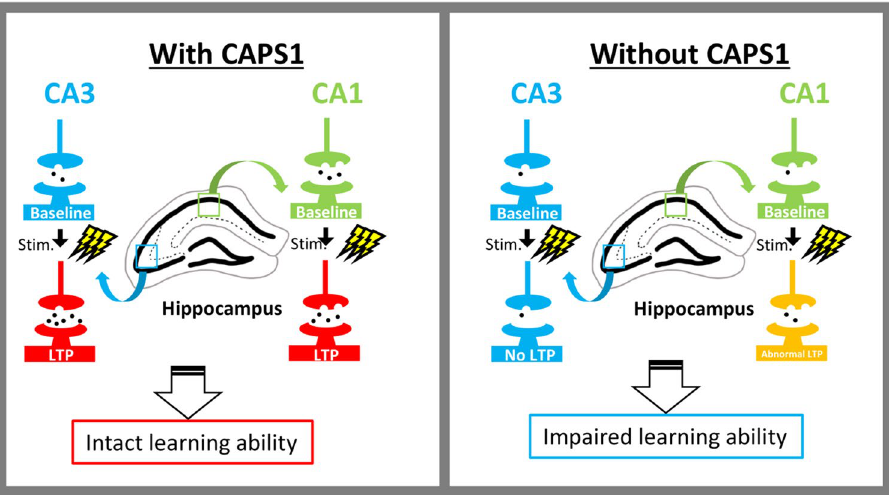
Figure 8. Schematic illustration of the role of CAPS1 in the hippocampal neural circuit and learning ability. Left: Physiological characteristics of the hippocampal neural circuits (CA3 and CA1 regions) with CAPS1. SVs are ready for exocytosis because CAPS1 renders SVs “docked” state, resulting in full LTP induced by TBS in both the CA3 and CA1 regions. This physiological plasticity is required for an intact learning ability. Right: Physiological characteristics of the hippocampal neural circuits (CA3 and CA1 regions) without CAPS1. SVs are to be away from the active zones because the absence of CAPS1 is insufficient to render SVs “docked” state, resulting in no or insufficient LTP induced by TBS in CA3 or CA1 regions, respectively. These physiological abnormalities underlie impaired learning